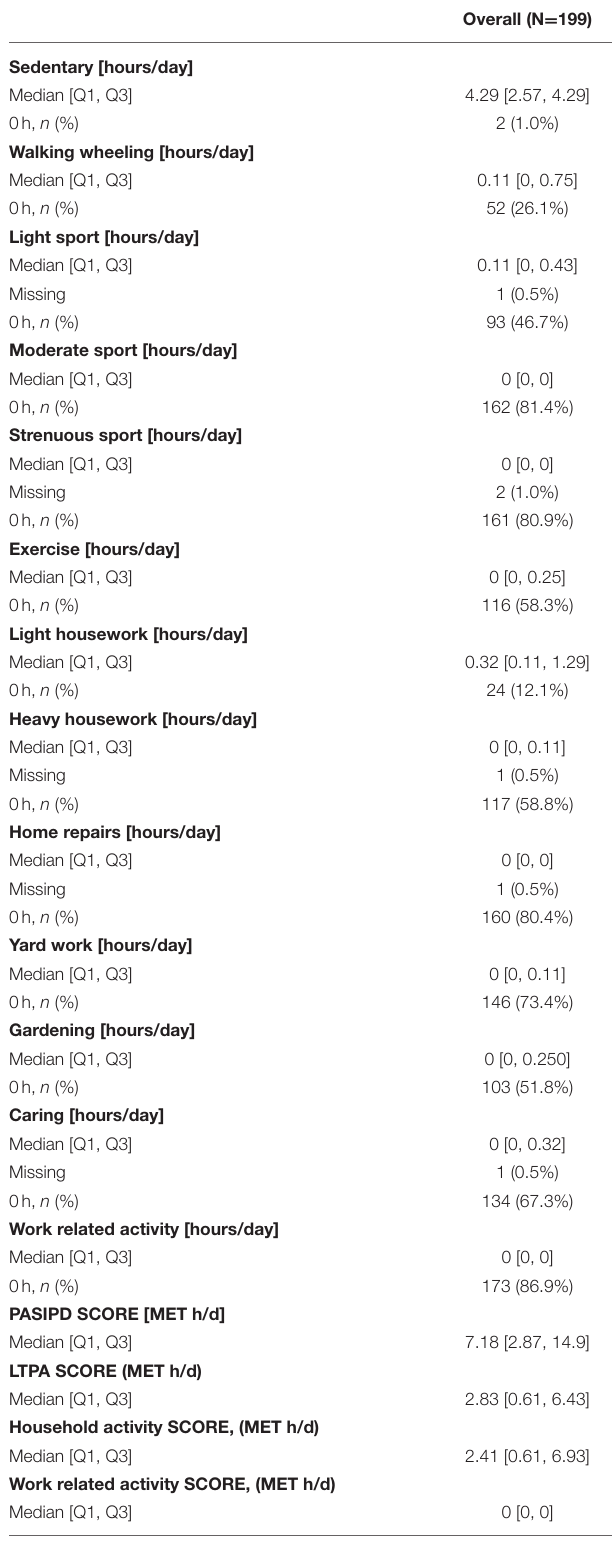
TABLE 3 | Summary of physical